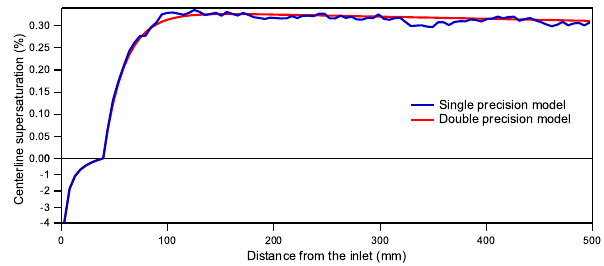
Fig. B1. Centerline supersaturation profiles from the single and dou- ble precision models after 1000 iterations. Note that there are dif- ferent scales for sub- and supersaturated